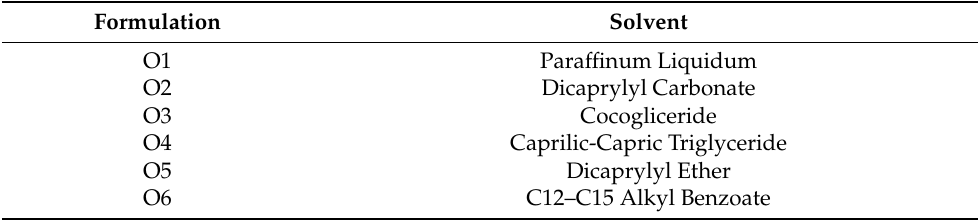
Table 1. List of selected